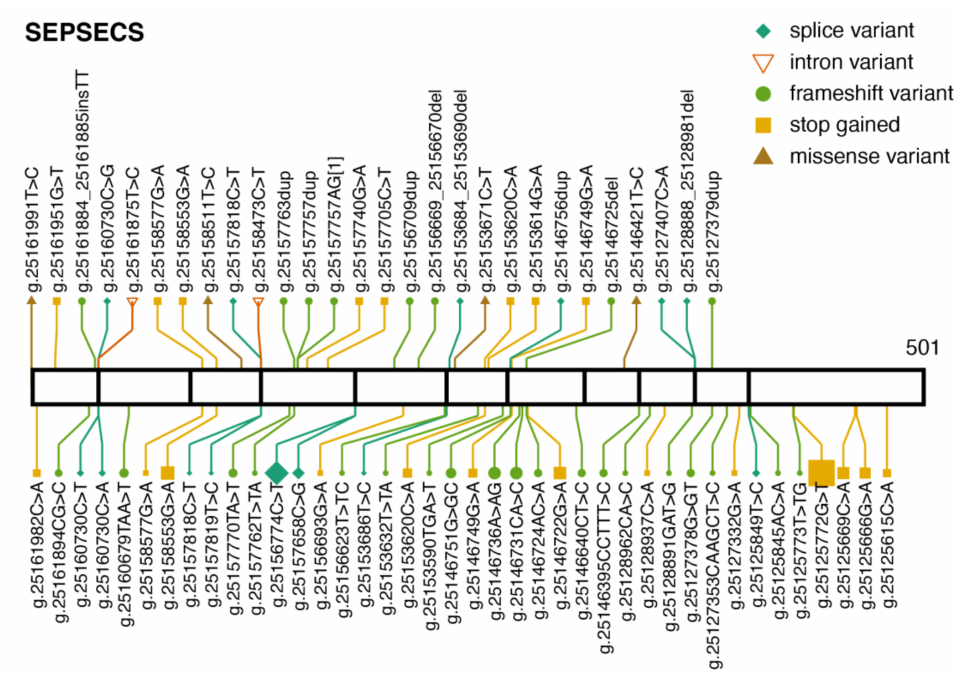
Figure 6. Pathogenic variants and protein-truncating variants in SEPSECS. Location of ClinVar pathogenic variants (above) and gnomAD protein-truncating variants (below) along the SEPSECS protein sequence. The same aesthetics as Figure 1b are used. SEPSECS transcript: